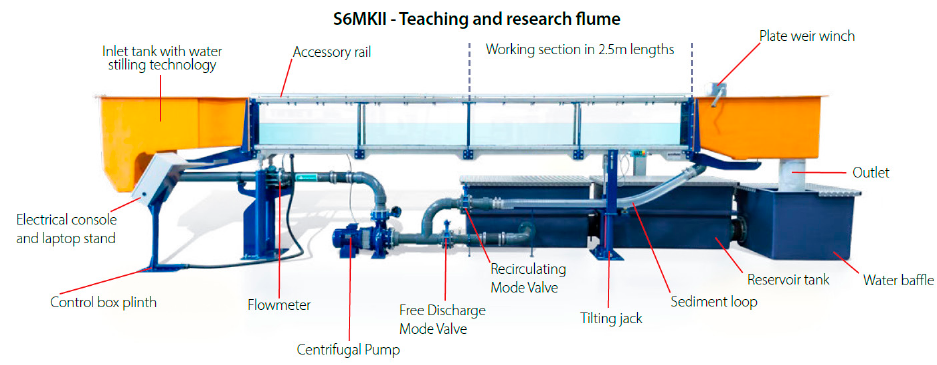
Fluids 2020 , 5 , x FOR PEER REVIEW Figure 2. Armfield S6-MKII laboratory flow channel. Figure 2. Armfield S6-MKII laboratory flow channel. Table 1. Characteristics of the weir models.